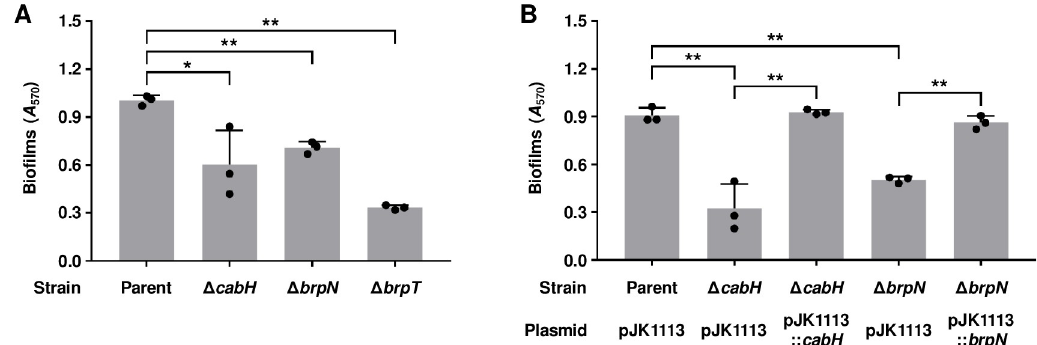
Fig 6. Biofilm formation of the cabH and brpN mutants. (A, B) For quantitative analysis of the biofilm, biofilms of the V . vulnificus strains were grown in VFMG supplemented with 0.01% arabinose (A) or 0.01% arabinose, 100 μ g/ml kanamycin, and 100 μ g/ml ampicillin for complementation experiments (B) in 96-well polystyrene microtiter plates for 24 h. Then supernatants were removed from the wells and the remaining biofilms were stained with 1% crystal violet. The crystal violet was eluted and its A 570 was determined to quantify the biofilms ( n = 3). Error bars represent the SD. Statistical significance was determined by the Student’s t test ( � , P < 0.05; �� , P < 0.005). Parent and Parent (pJK1113), parent strain; Δ cabH and Δ cabH (pJK1113), cabH mutant; Δ brpN and Δ brpN (pJK1113), brpN mutant; Δ brpT , brpT mutant; Δ cabH (pJK1113:: cabH ) and Δ brpN (pJK1113:: brpN ), complemented